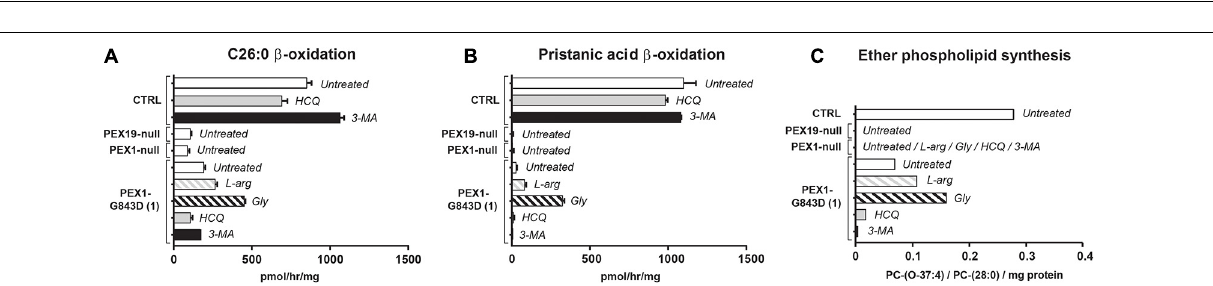
slightly after incubating the cells for 7 days with HCQ and